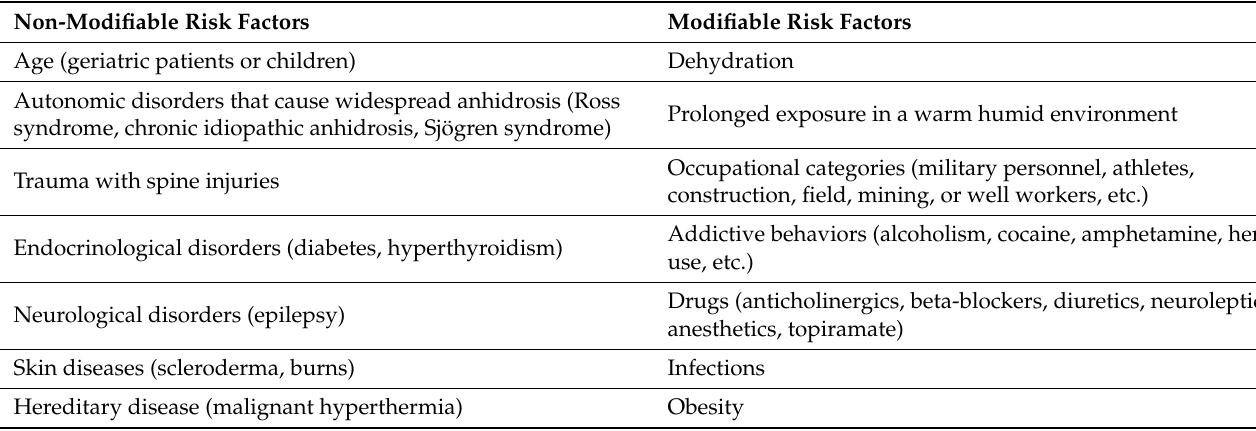
Table 1. Risk factors for heat related